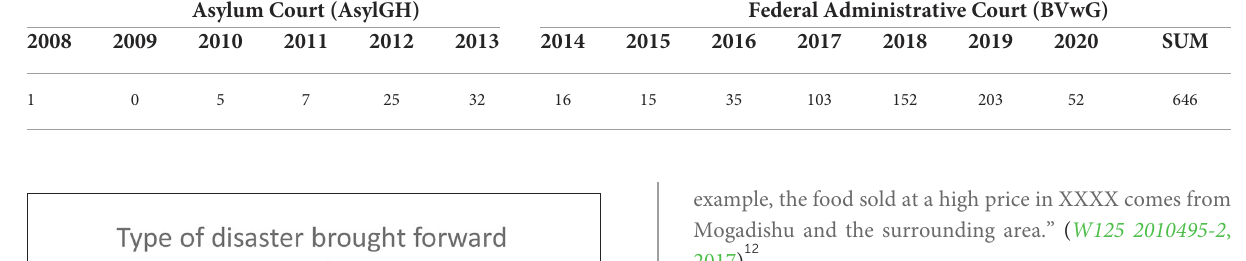
TABLE 1 Number of cases selected for in-depth analysis per year.